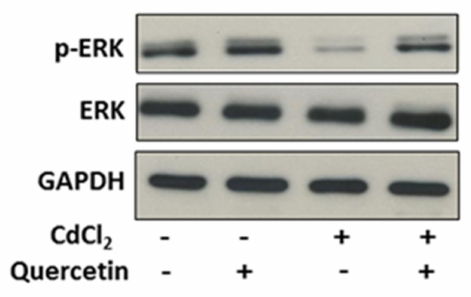
Figure 2. Effects of CdCl 2 and quercetin on ERK phosphorylation. Nthy-ori-3-1 cells were treated for 3 h with CdCl 2 10 µ M or/and quercetin 5 µ M as described in the Methods. Immunoblot analysis of phosphorylated ERK (p-ERK) and total form of the enzyme (ERK) was performed by Western blotting. GAPDH was used as loading control. An immunoblot representative of three experiments is shown.